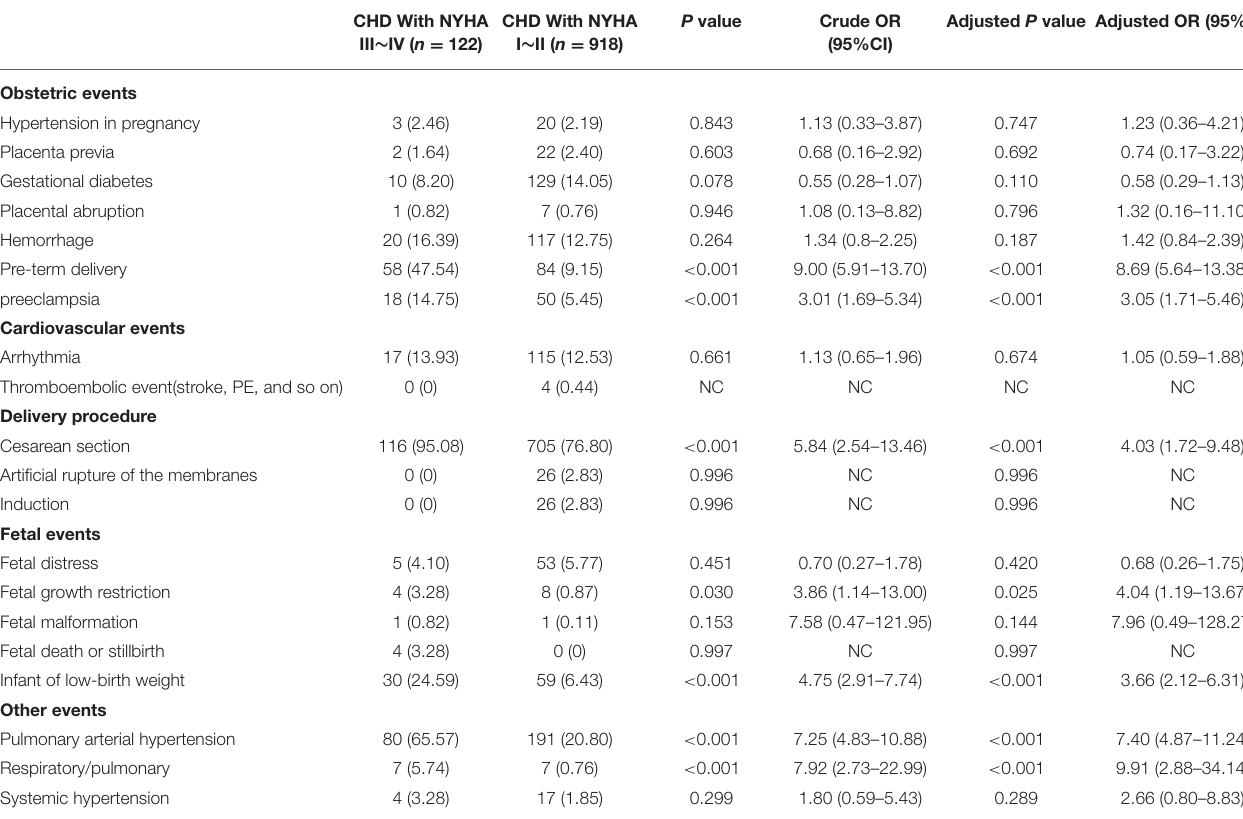
TABLE 4 | Adverse cardiovascular, obstetric, and fetal events experienced by women with CHD admitted for delivery by